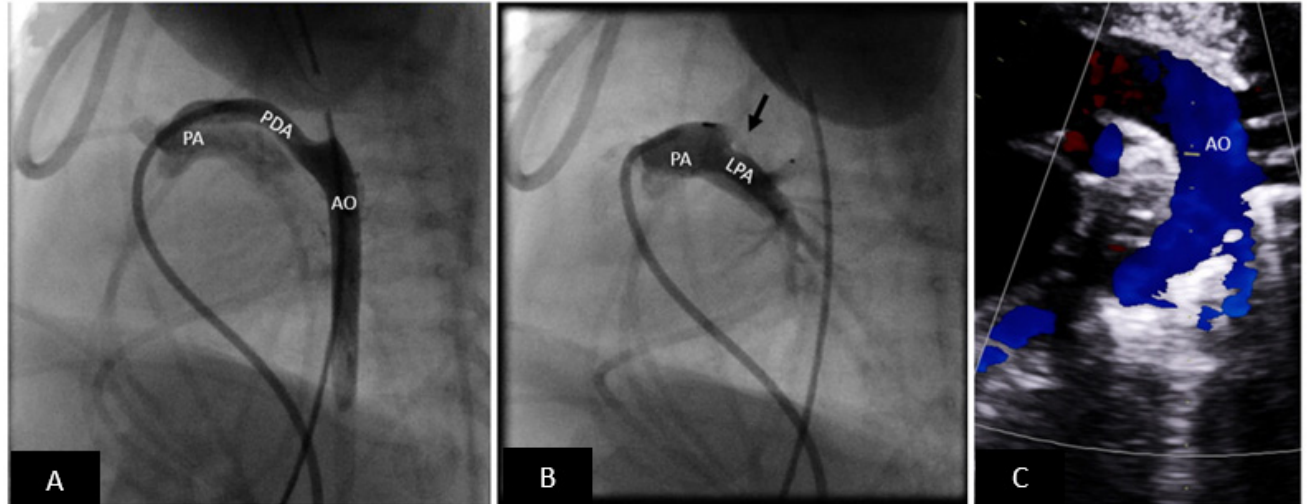
Figure 4. Premie PDA closure with microvascular plug (MVP). ( A ) Lateral angiogram showing a long tubular PDA. ( B ) PDA successfully closed with an MVP device (off-label use) (black arrow). The angiogram shows that there is no obstruction to the left pulmonary artery. ( C ) Transthoracic echocardiogram showing an unobstructed arch. There is no residual shunting. Echocardiographic assessment is critical to eliminate the need for arterial access. PA = pulmonary artery, LPA = left pulmonary artery, AO = aorta, PDA = patent ductus arteriosus.